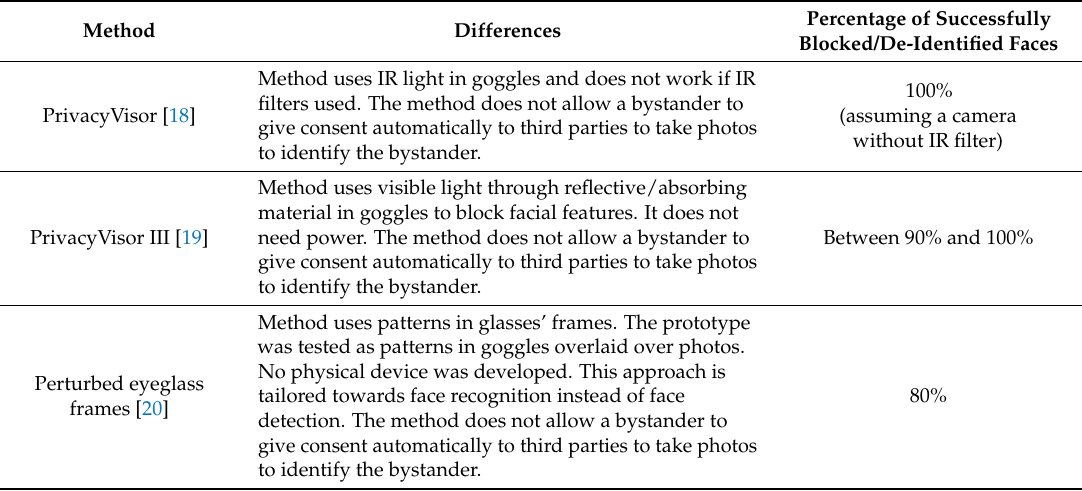
Table 5. Salient differences between FacePET and similar methods under the bystander-based obfuscation category. The third column (percentage of successfully blocked/de-identified faces) corresponds to the percentage of blocked/de-identified faces in experiments for each